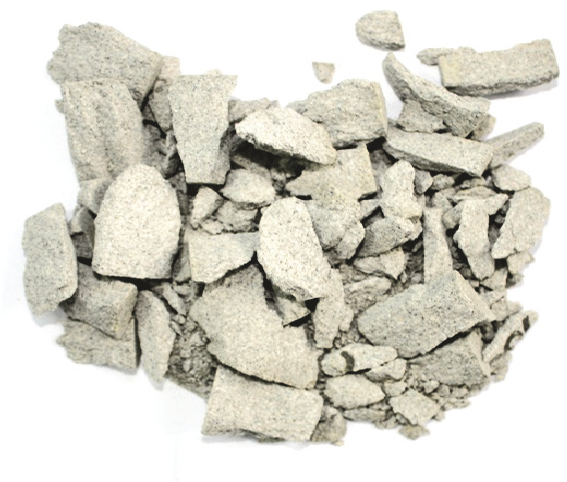
Figure 16: Failure modes of specimens in the SHPB test (the length-diameter ratio of specimen is 0.5, and the average strain rate is 162s −1 ).